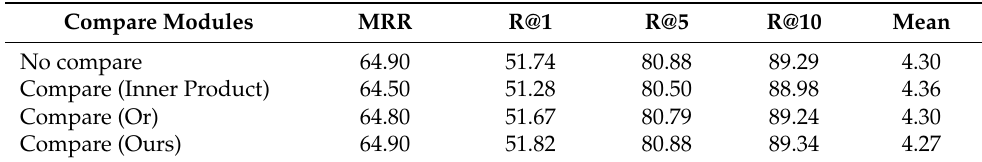
Table 4. Performance comparison among Compare modules.